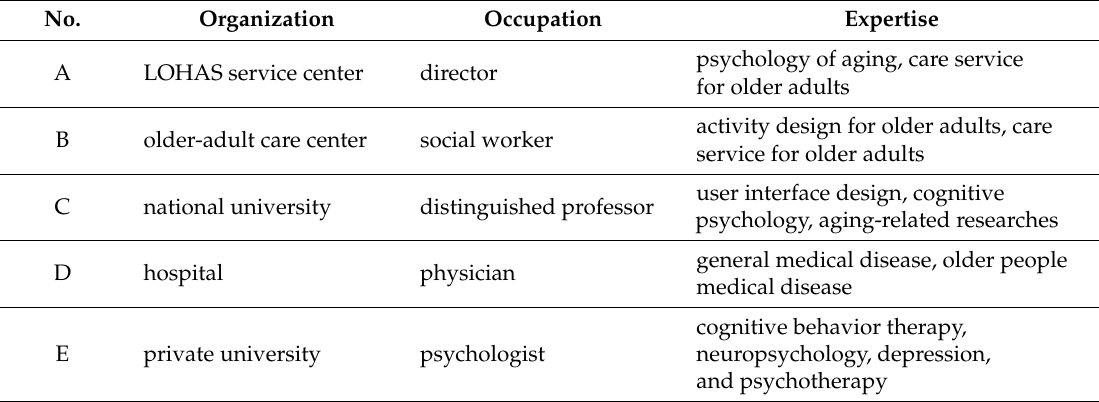
Table 2. List of the backgrounds of invited experts interviewed in this study.